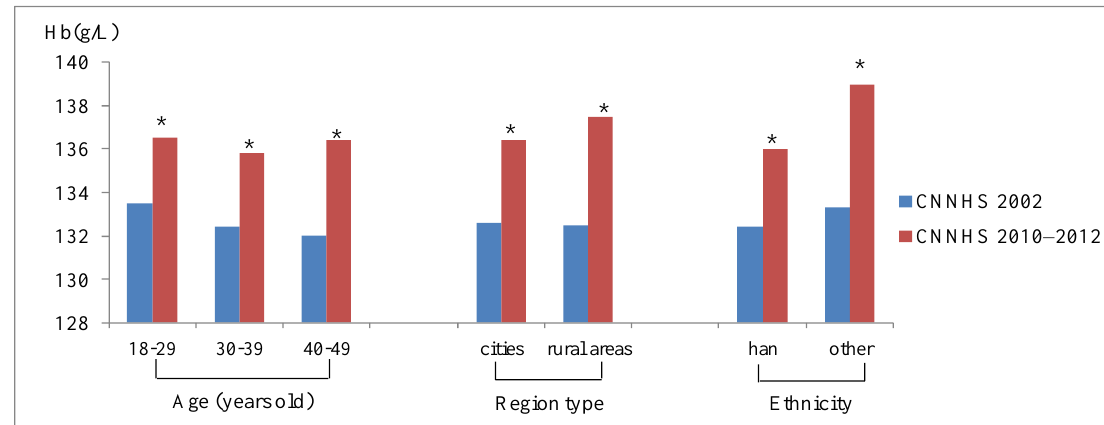
Figure 2. Blood hemoglobin concentration of the fourth Chinese national nutrition and health survey (CNNHS 2002) and the fifth CNNHS 2010 – 2012, stratified by demographic characteristics. (*significant differences between CNNHS 2010 and 2002, P < 0.001).